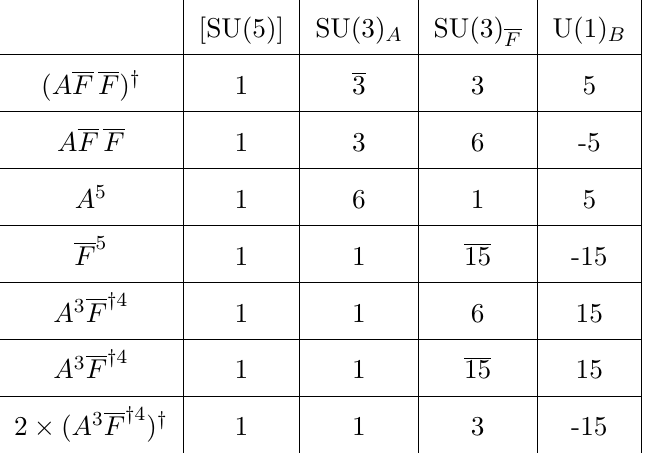
Table 2 . One possible solution to the anomaly matching conditions.